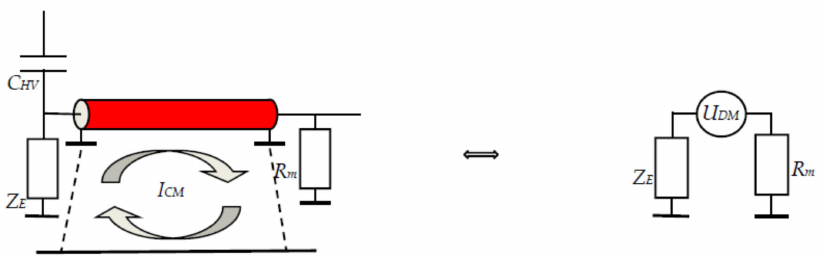
Figure 2. E ff ect of induced ground currents along the measurement cable ( left ); Through the cable transfer impedance the resulting common mode current I CM causes a di ff erential mode voltage U DM which divides over the impedances at the cable ends ( right